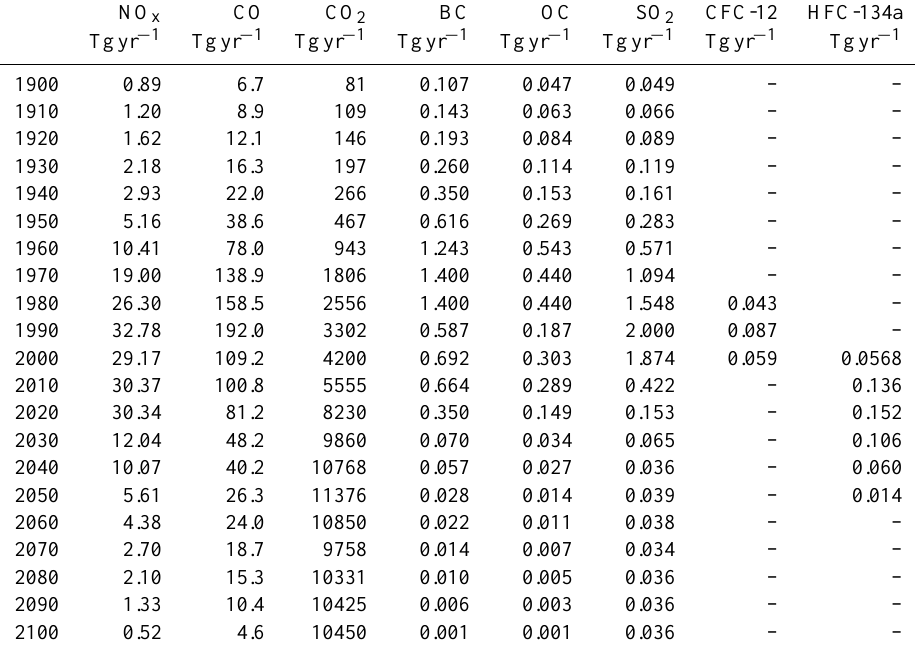
Table 1. Time series of road transport emissions (Borken et al., 2007; Uherek et al., 2010, http://www.ip-quantify.eu/). NO x emissions are given as equivalent NO 2 .